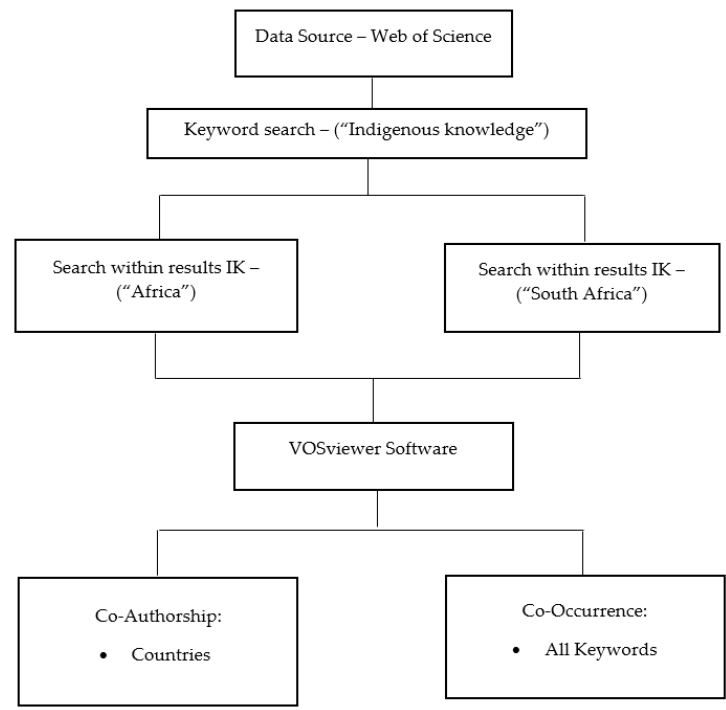
Figure 1. A flowchart of the systematic bibliometric review.